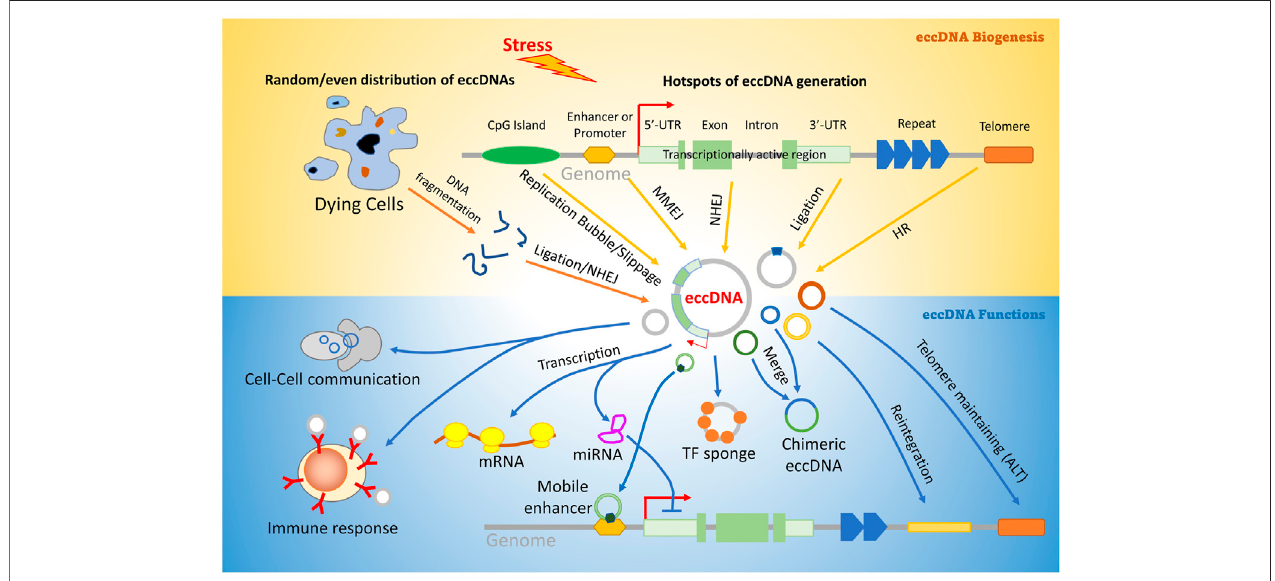
FIGURE 3 | Pathways involved in eccDNA biogenesis and function. Stress may induce aberrant DNA replication, transcription, or even genomic DNA broken into random fragments, and generate linear DNA fragments. Some of them are ligated and circularized by DNA damage repair pathways including HR (homologous recombination),NHEJ(Non-homologousendjoining),LigationbyDNAligasesIVandIII,andMMEJ(microhomologymediatedend-joining).EccDNAscanregulatemany downstream biological procedures including transcription, telomere protection, gene translocation, immune response, and cell – cell communication. Description about details can be found in the